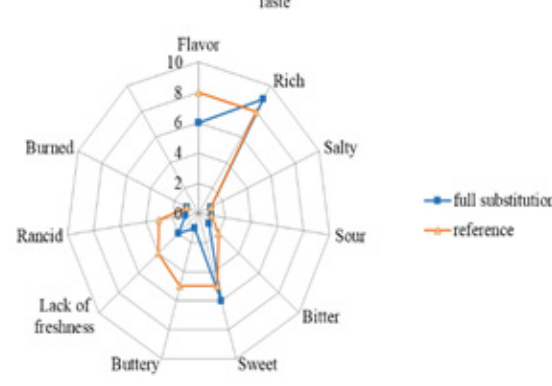
Figure 6: The results of the hedonic test about the taste